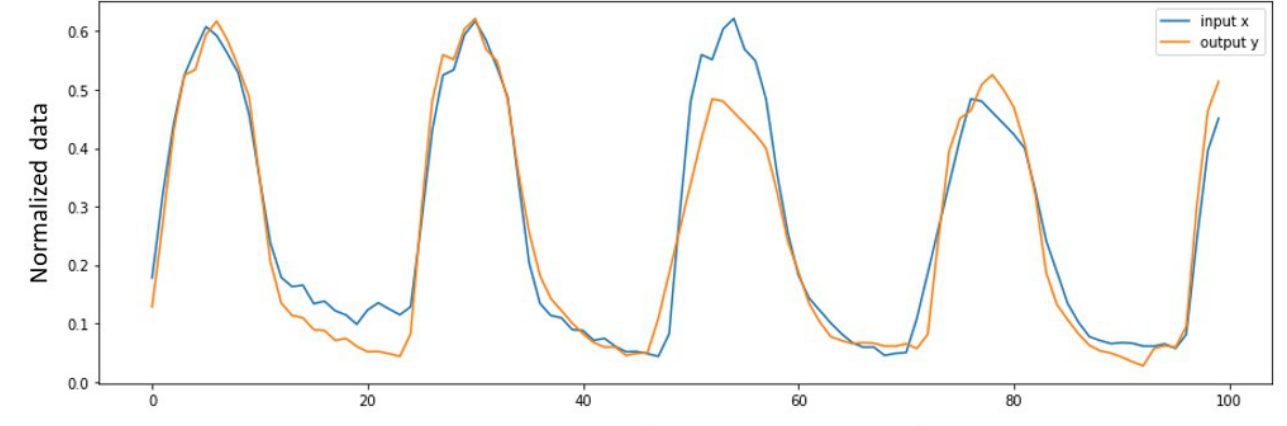
Figure 5. Plot of dataset after shift stepping.